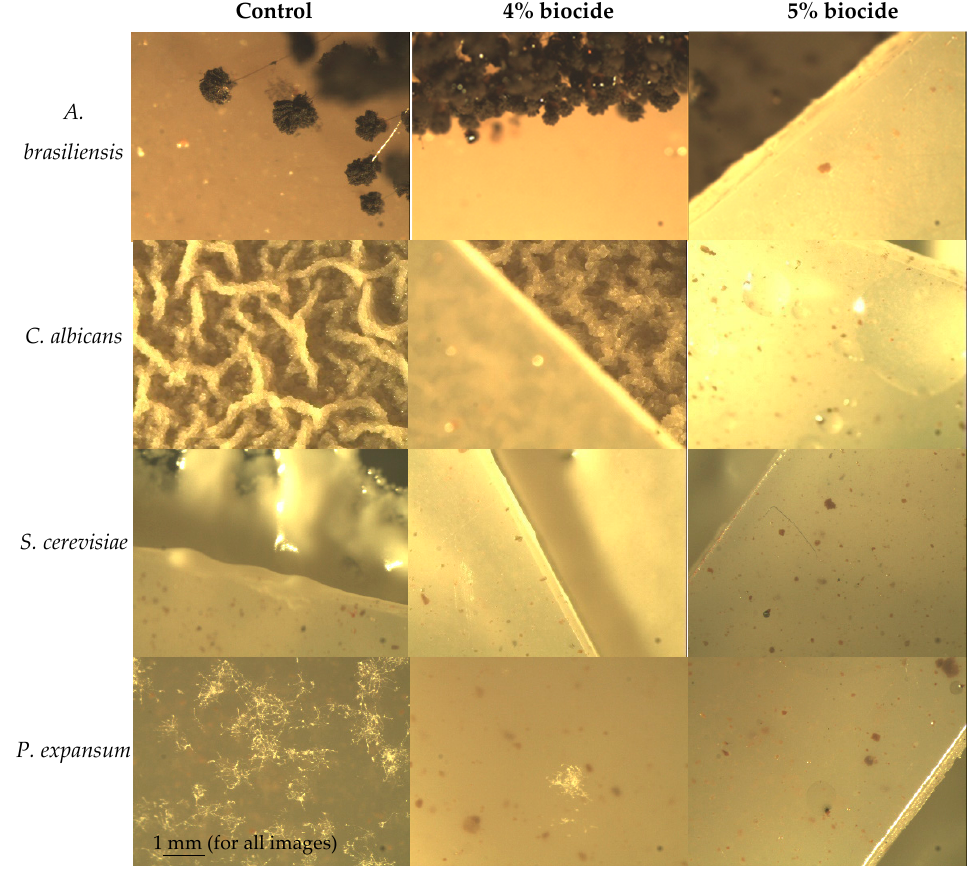
Figure 3. Microscopic evaluation of fungal growth on samples at 42× magnification of the sample image (selected variants).